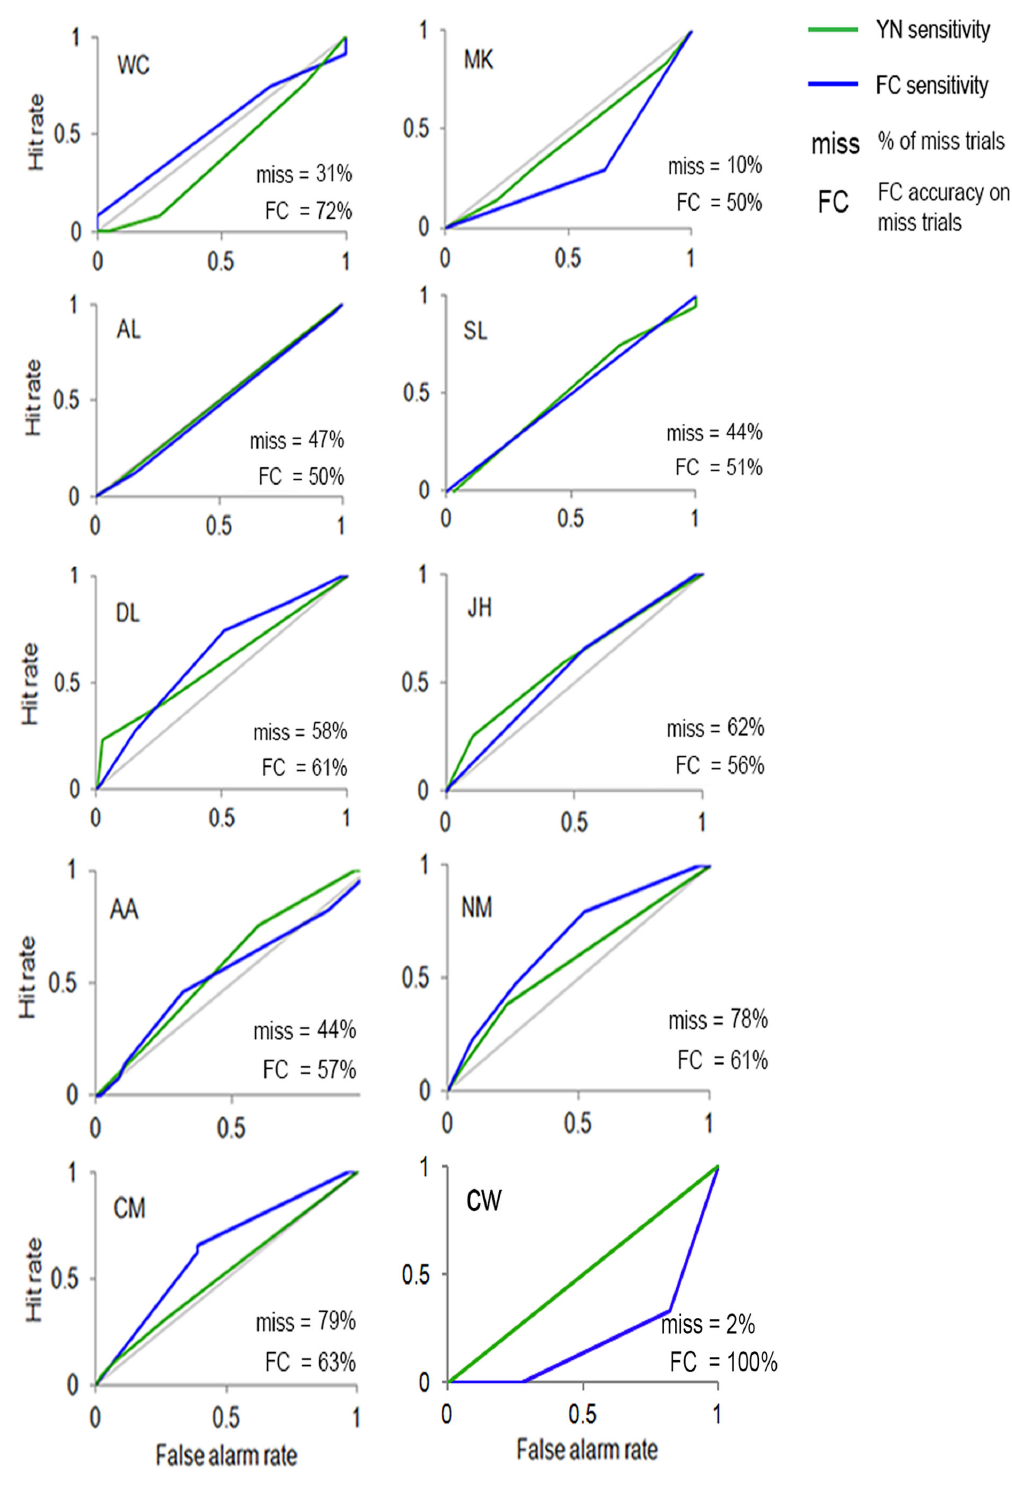
Figure 3. ROC curves. ROCs representing visual sensitivity in the absence of visual awareness under TMS stimulation of Occipital Cortex. The green lines represent ROCs fitted to confidence ratings for “no” responses in the Yes-No task, which refers to when subjects said they did not see the visual stimulus. The ROCs in blue are based on confidence ratings for forced-choice judgments that subjects made after reporting “no” to seeing the stimulus. doi: 10.1371/journal.pone.0082828.g003 PLOS ONE |